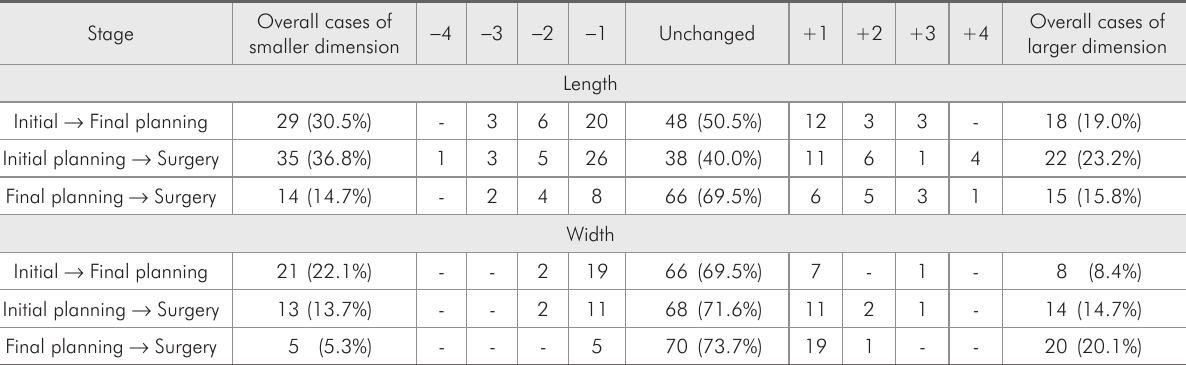
Table 2 - Descriptive distribution of implant length and width changes at different implant planning and placement